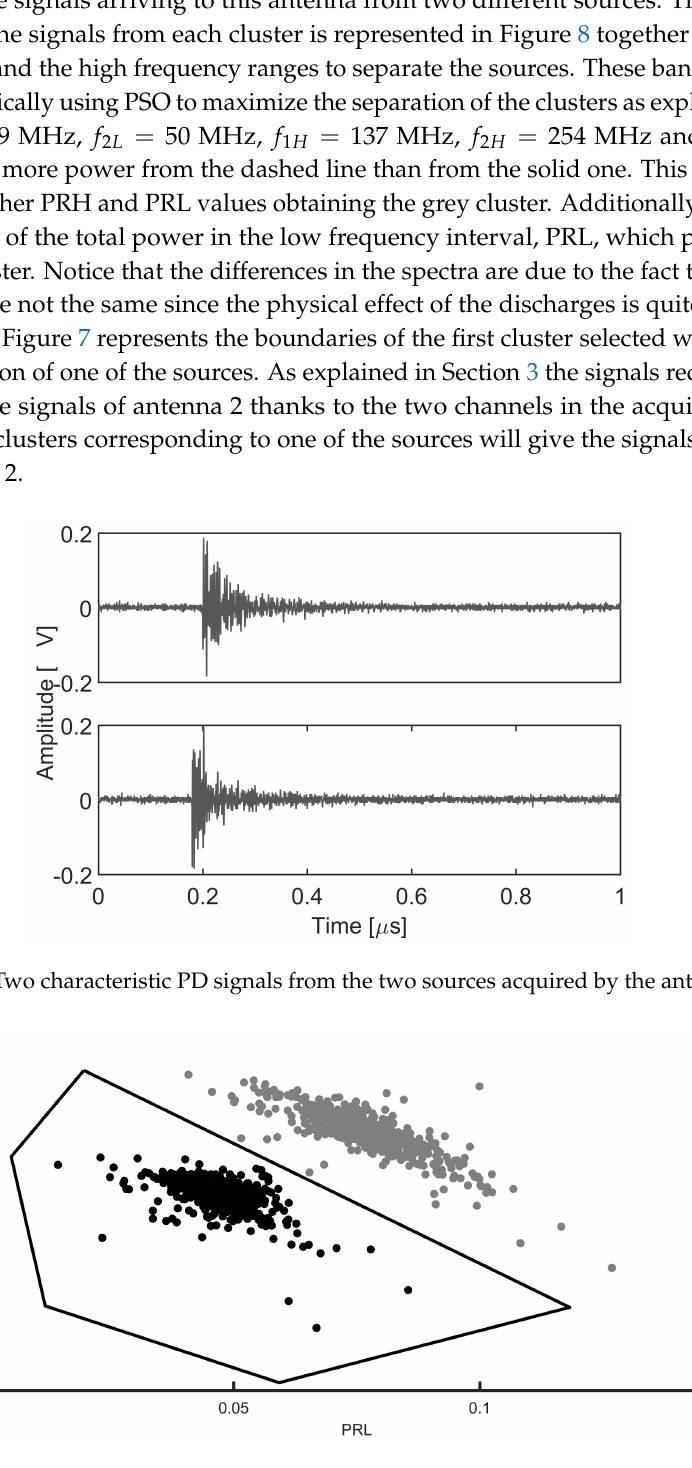
Figure 7. Signals received by antenna 1 represented in a PR map where the differences in the power spectral density corresponding to two sources distributes the signals into